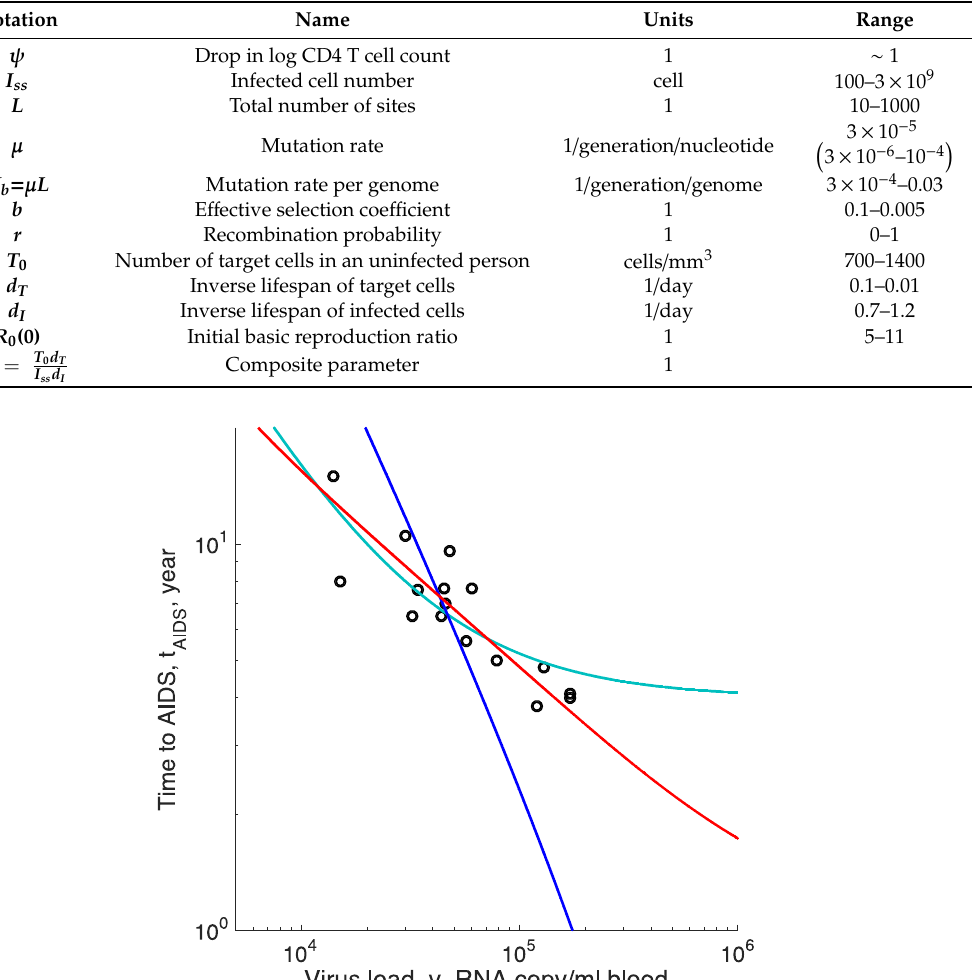
Table 1. Model parameters relevant in the quasi-steady state.